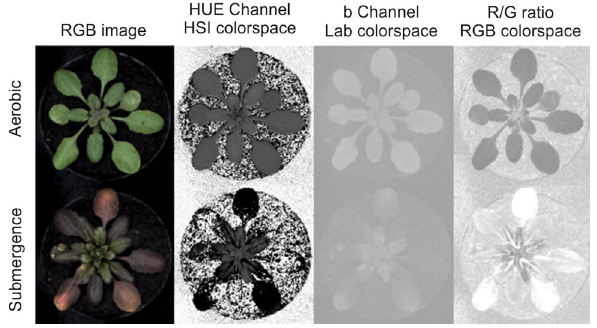
Figure 1. Arabidopsis grown under aerobic and submerged conditions to illustrate the reduced color contrast arising from the stress treatment in the HUE channel (HSI colorspace) b channel (Lab colorspace) and the Red/ Green ratio (RGB colorspace). While the aerobic plant shows color contrast to the background, this contrast is greatly reduced for the submerged